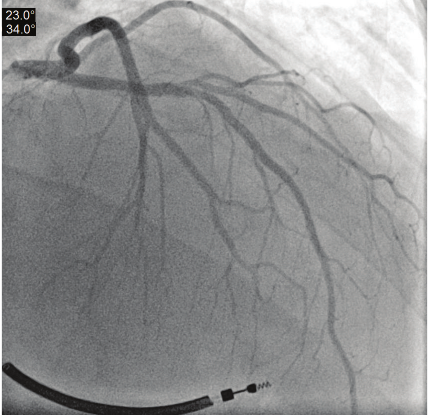
Figure 4: Cardiac catheterization showing normal coronary arter-